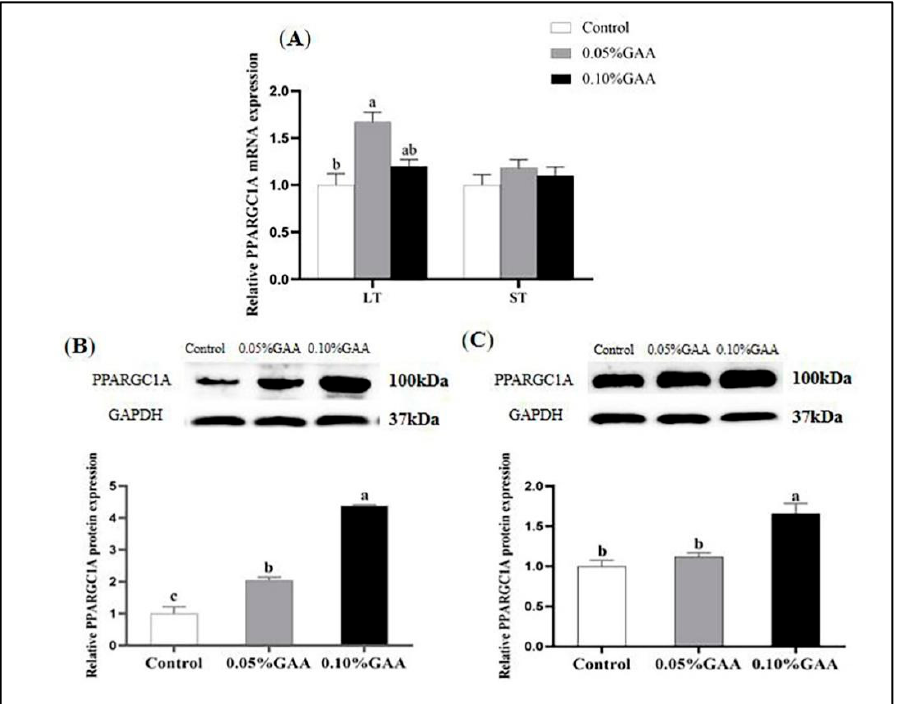
Figure 3. Effects of guanidinoacetic acid supplementation on the mRNA ( A ) and protein expressions of PPARGC1A of longissimus thoracis muscle ( B ) and semitendinosus muscle ( C ) in finishing pigs. Means with different letters differ significantly ( p < 0.05). Values are presented as the mean ± SEM ( n = 5). Control: Finishing pigs were fed a basal diet; 0.05% GAA or 0.10% GAA: Finishing pigs were fed a basal diet supplemented with GAA at 500 or GAA at 1000 mg kg − 1 . LT: Longissimus thoracis muscle; ST: Semitendinosus muscle; PPARGC1A: Peroxisome proliferator activated receptor- γ coactivator-1alpha.